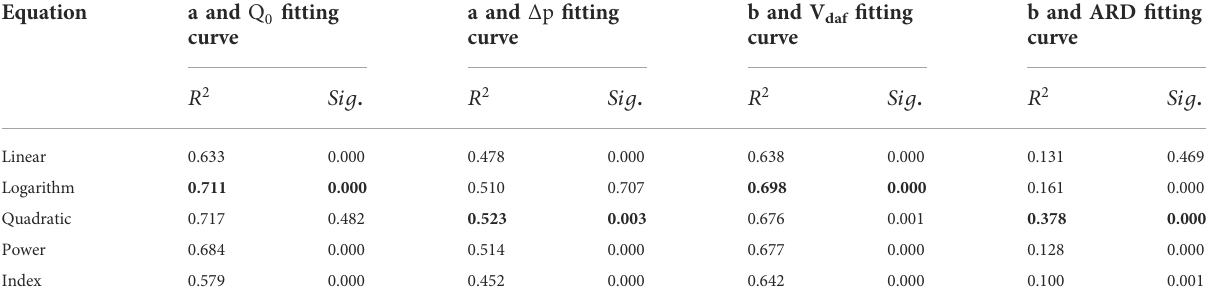
TABLE 2 Estimated results of gas adsorption constants a and b curves. Equation a and Q 0 fi tting curve